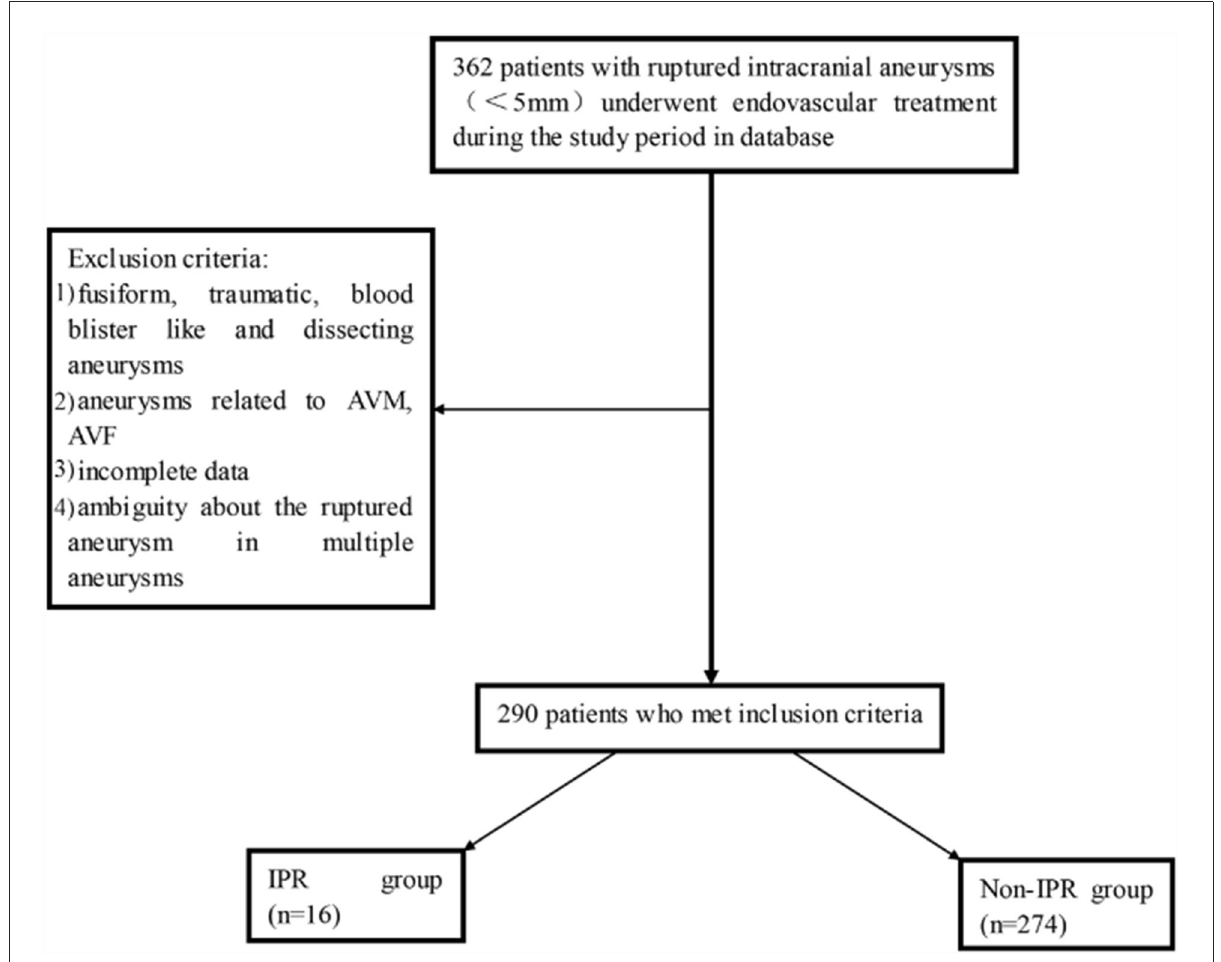
FIGURE1 The patient inclusion flowchart. AVM, arteriovenous malformation; AVF, arteriovenous fistula; IPR, intraprocedural